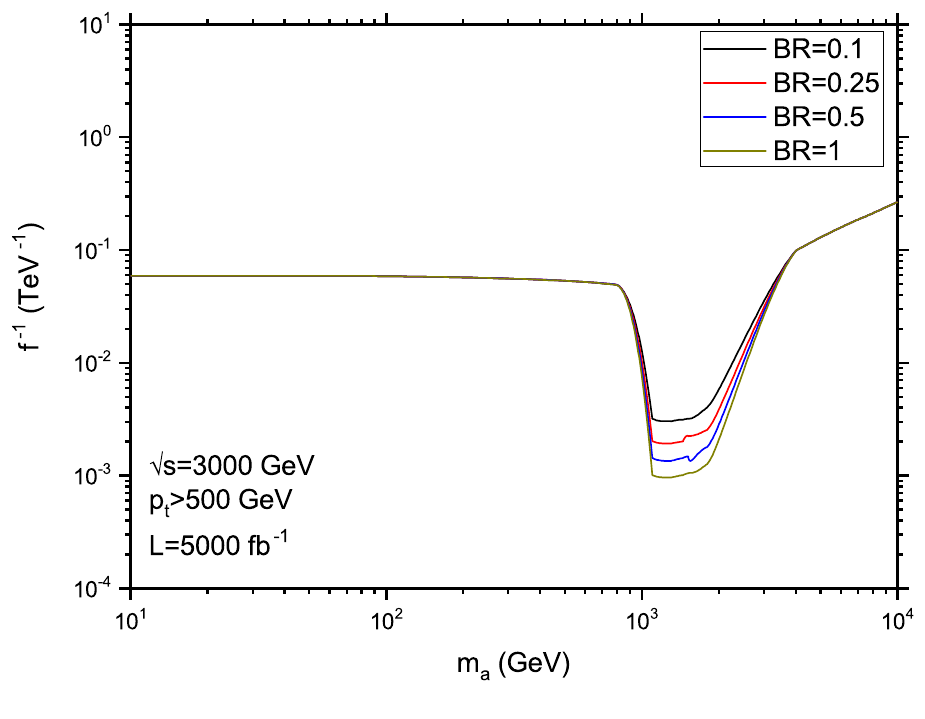
Figure 13 . The same as in figure 12, but for √ s = 3000 GeV and L = 5000 fb − 1 . M ++++